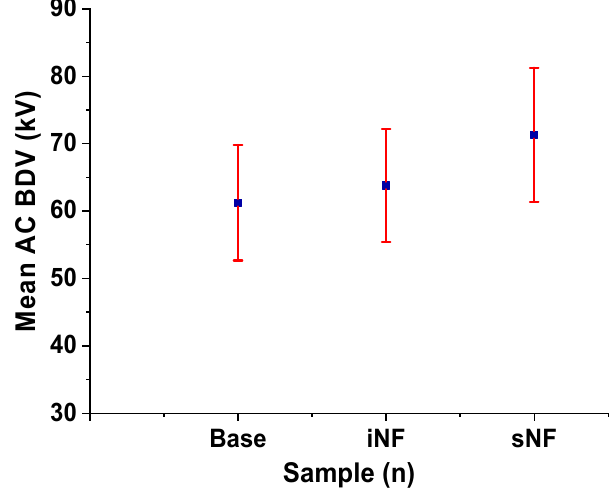
Figure 5. Mean AC BDVs and standard deviation of the NF and base oil samples.